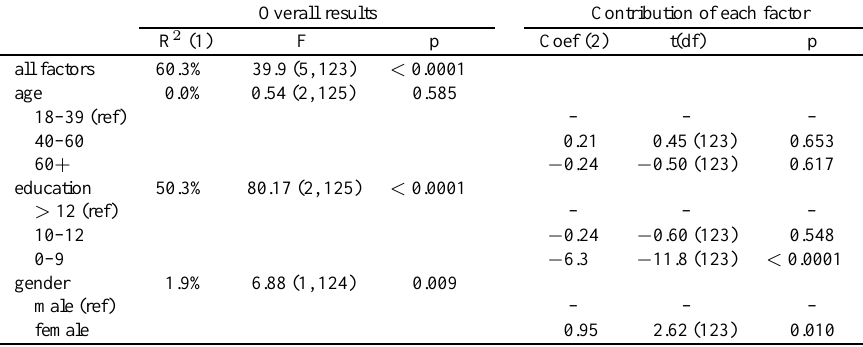
Table 4 Predictors of the writing subtest